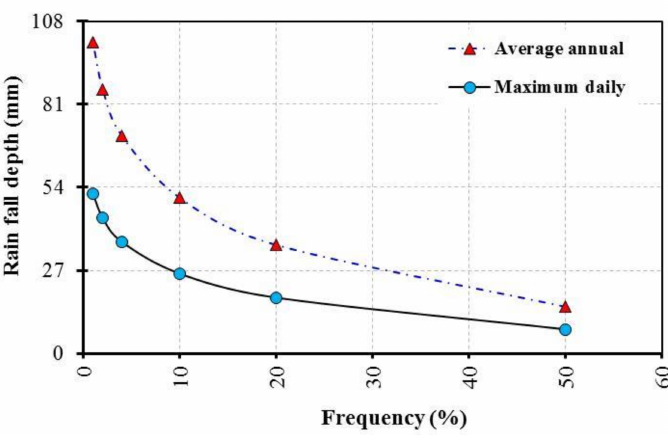
Figure 2. Relation between rainfall depth and frequency for El Tor